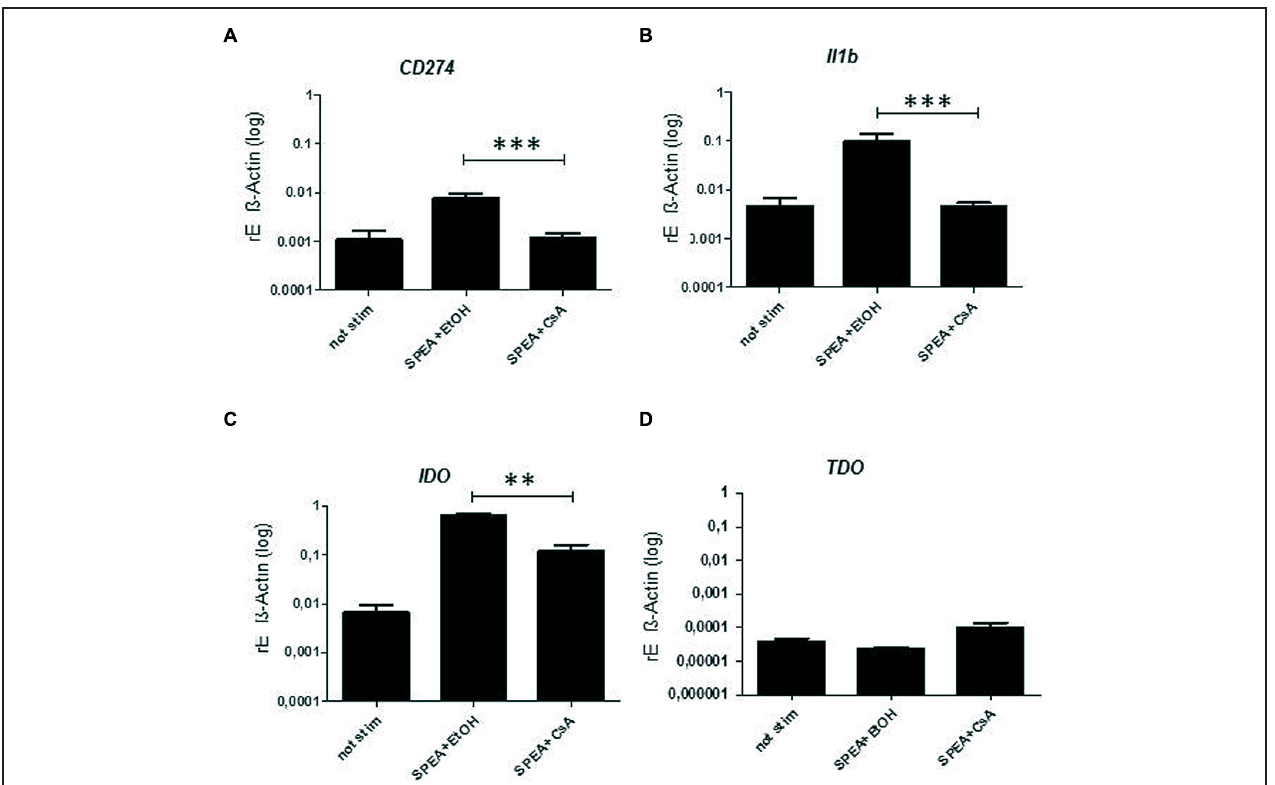
FIGURE 7 | Cyclosporine A – mediated expression of mRNA. CD14 + monocytes were stimulated 24 h with SPEA (100 ng/ml) and CsA (1 μ M) or Ethanol (equal volume to CsA). Quantitative real-time PCR of cDNA was performed with sequence-specific primers for (A) CD274, (B) Il1b, (C) IDO, (D) TDO. Data were normalized to ß-Actin. Shown is the mean and standard deviation of 5 donors. Statistical analysis was performed using a Multiple Comparison of Means (Tukey Contrasts). Significance codes: 0 ‘ ∗∗∗ ’; 0.001 ‘ ∗∗ ’; 0.01 ‘ ∗ ’.